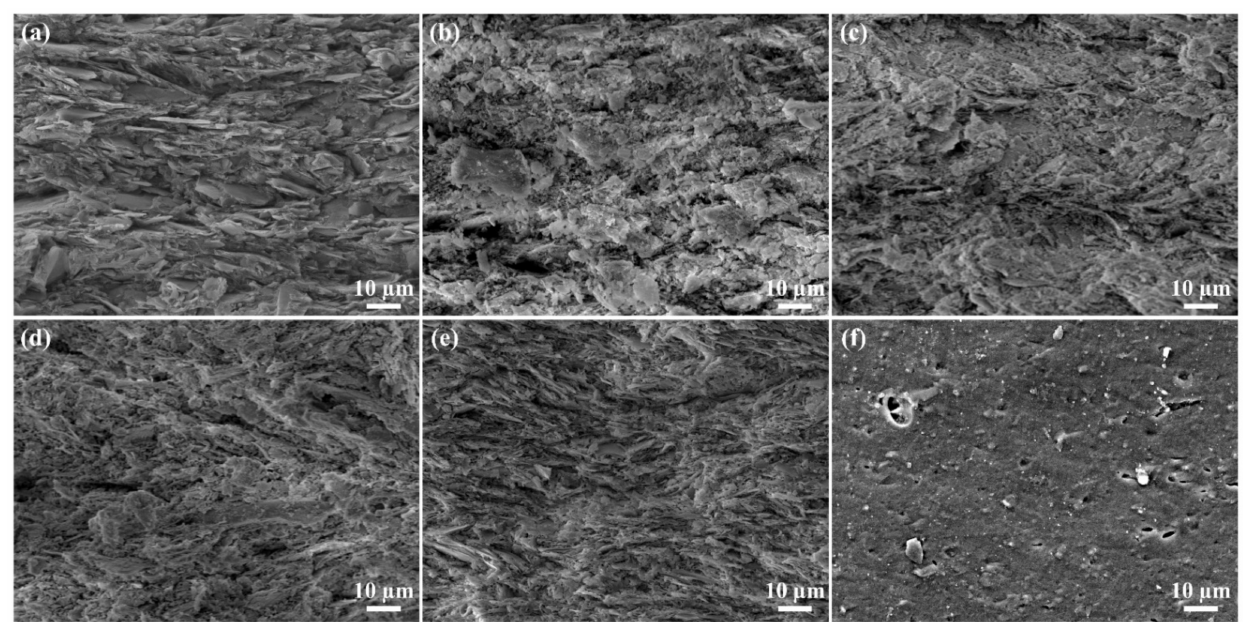
Figure 7. FE-SEM images of the microstructure of the ( a ) mica green body; ( b ) debound body; and sintered body at ( c ) 800 ◦ C, ( d ) 900 ◦ C, ( e ) 1000 ◦ C, and ( f ) 1100 ◦ C.